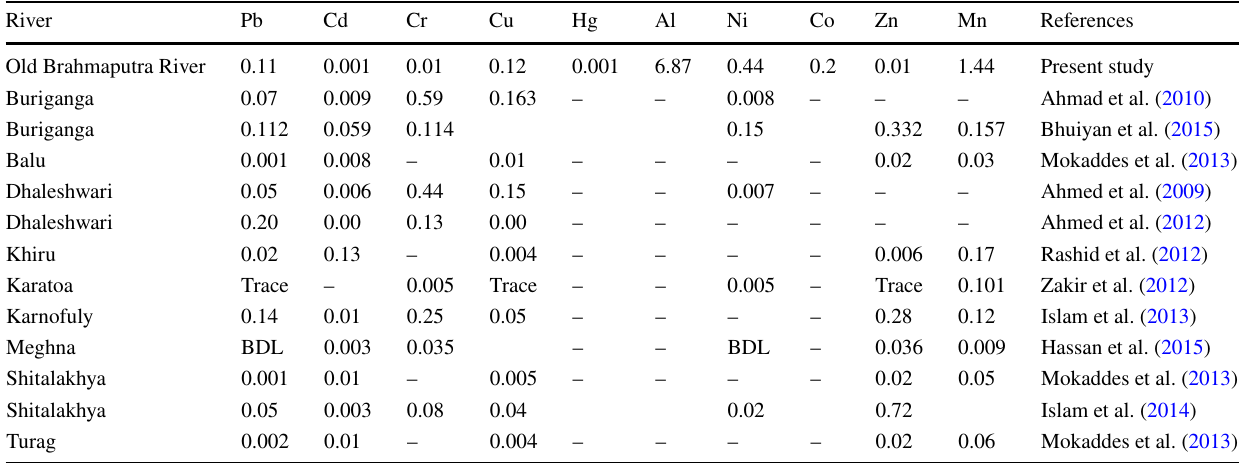
Fig. 2 Graph showing mean concentrations (mg/l) of heavy metals in water during three